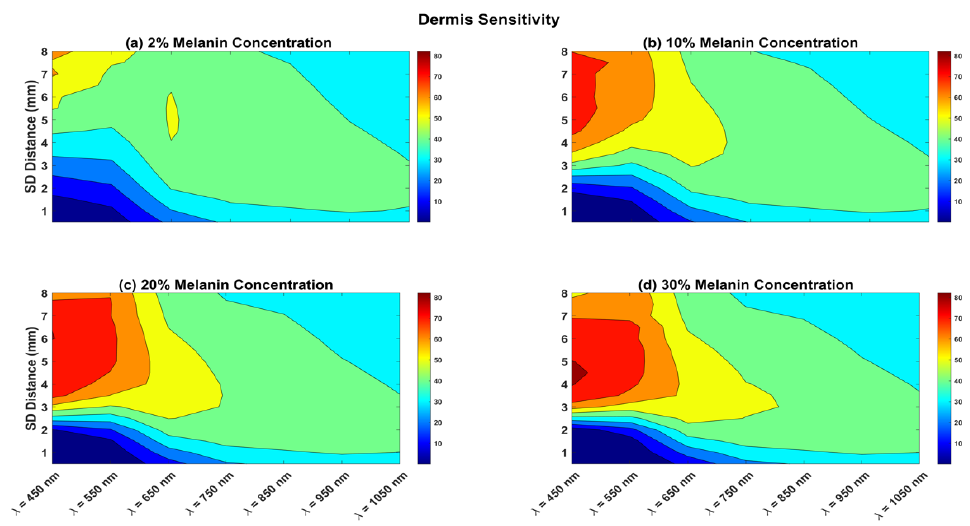
Figure 4. Dermis sensitivity for various melanin concentrations and with the wavelength ranging between 450 and 1050 nm. Sensitivity also shown for SDS ranging from 0.5 to 8 mm.